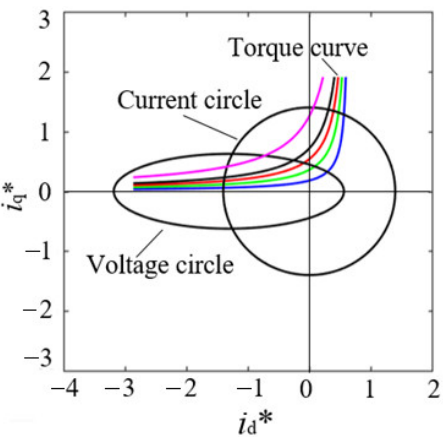
Figure 3. The torque curve in plane of the d-q axis with per unit value of i d - i q .